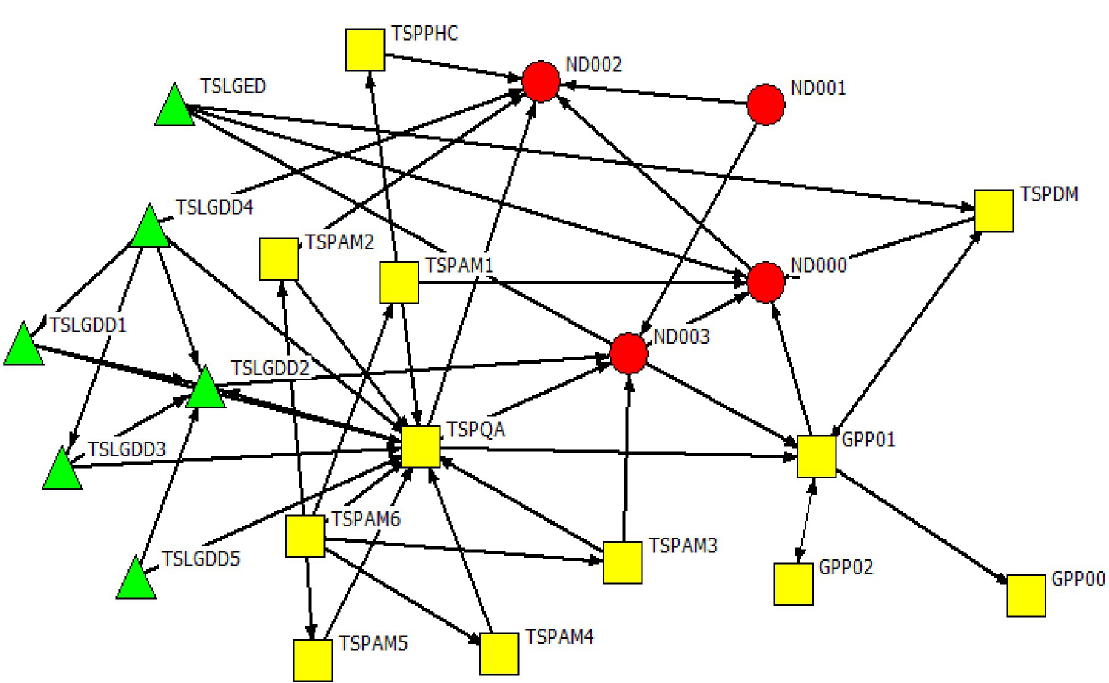
Fig 5. Gauteng province network: Receiving information. Colour and Shape of nodes: red circle = National, yellow square = Provincial, and green triangle = Local Government. Nodes labels: ND = A label starting with TSP or GP refers to a provincial actor, TSLG = A label starting with TSLG refer to a local government actor.